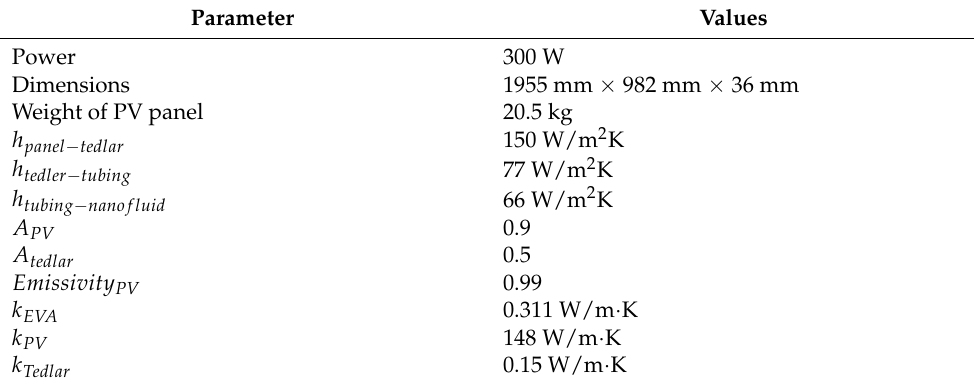
Table 3. Specifications and properties of the PV/T system Nasrin, et al.